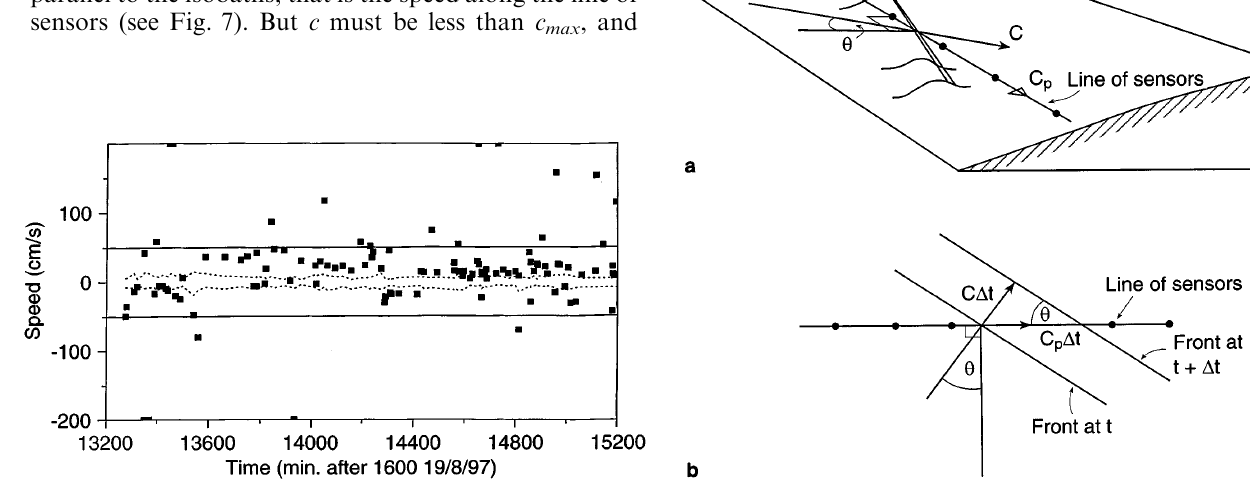
Fig. 6. The speed of events ( points ) and the maximum and minimum along-slope currents relative to the mean depth-averaged along-slope current. The lines at + or ) 0.5 ms ) 1 indicate the range of speeds of waves propagating parallel to isobaths